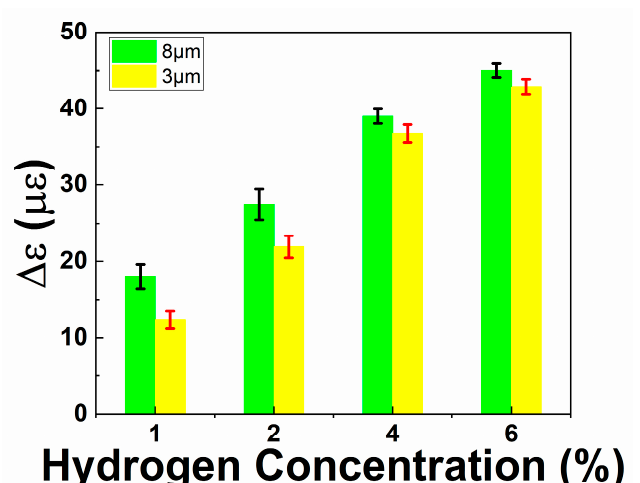
Figure 3. Hydrogen-induced tensile strain changes for the sensor with 3- µ m thick functional coating layer vs. sensor with 8- µ m thick coating. The error bars are calculated according to standard deviation formula [24].